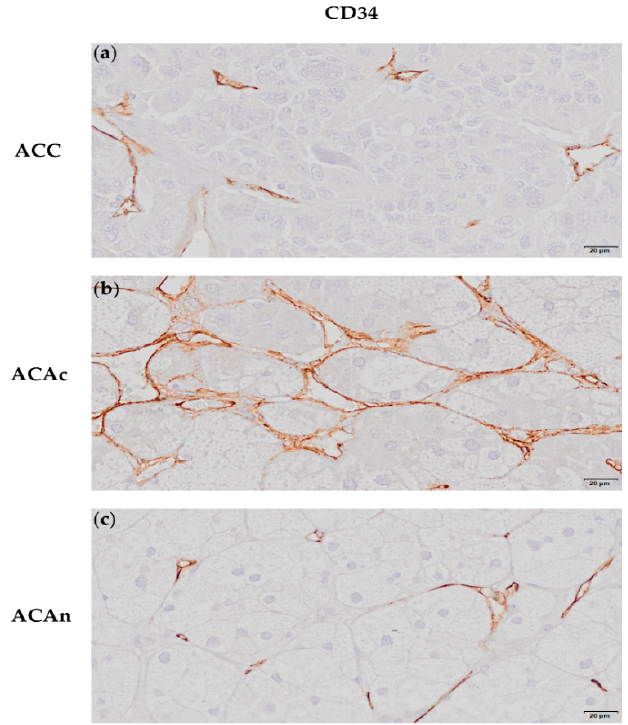
Figure 1. Immunochemistry staining of an adrenocortical carcinoma (ACC) ( a ), adrenocortical adenoma with Cushing syndrome (ACAc) ( b ) and non-functioning adrenocortical adenoma (ACAn) ( c ) for CD34 (20 µ m). CD34 positively stains the endothelial cells ( a – c ). The percentage of CD34 staining area was significantly lower in ACC (4.023 ± 0.408%) when compared to both adrenocortical adenoma with Cushing syndrome